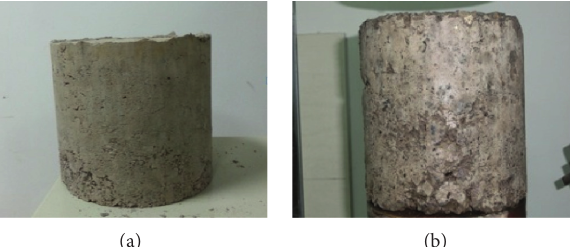
Figure 22: Appearance of test specimen (a) before and (b) after the freeze-thaw cycle. (a) Standard curing specimen. (b) Specimen after the fifth freeze-thaw cycle.